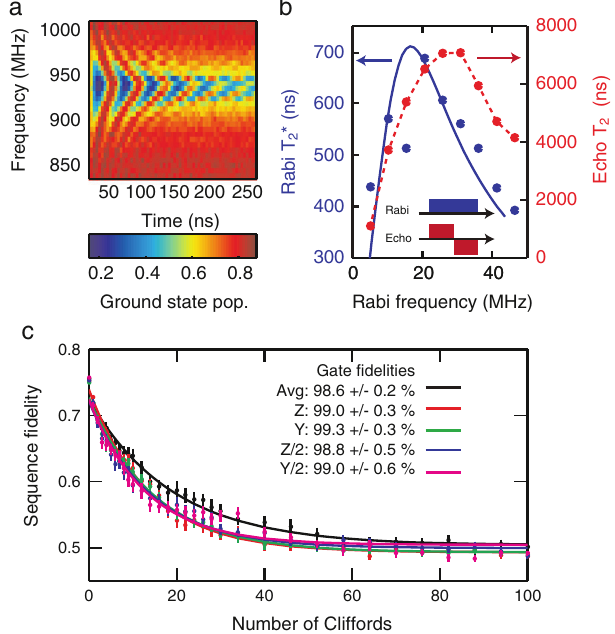
results from the wavefunction overlap between each electron and the Ga and As nuclear spins in the heterostructure. Although the nuclear spins are unpolarized in thermal equilibrium, Δ B z can be measured and stabilized up to several hundred mT using